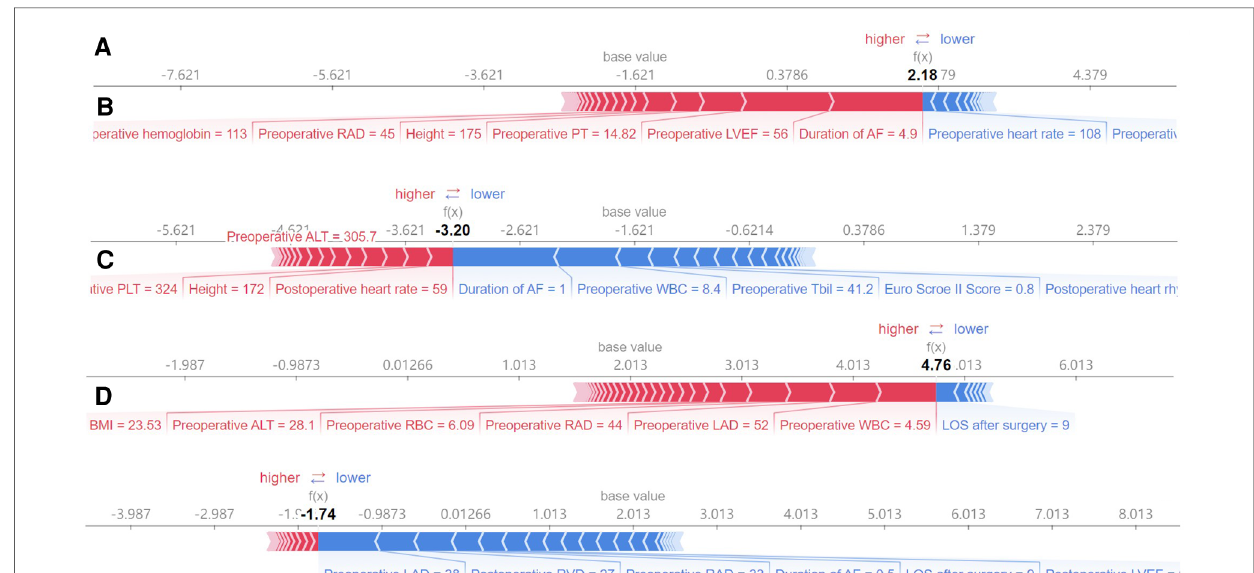
FIGURE 5 The SHAP force plots shown in A – D correspond to model-predicted risk scores for particular instances. The SHAP force plot is a graphical representation of the feature importance for a single sample in a machine learning model. The x -axis represents the different features, arranged from left to right. Each feature has a corresponding weight value, which indicates the impact of that feature on the prediction outcome. The size of the weight value indicates the magnitude of the impact of the feature on the prediction. The reference line represents the expected value of the prediction outcome if all feature values were set to their average value. The f(x) value represents the predicted outcome for the given sample. A,B show high and low risk examples for the CMP- IV group, respectively. C,D show high and low risk examples for the non-CMP-IV group, respectively.